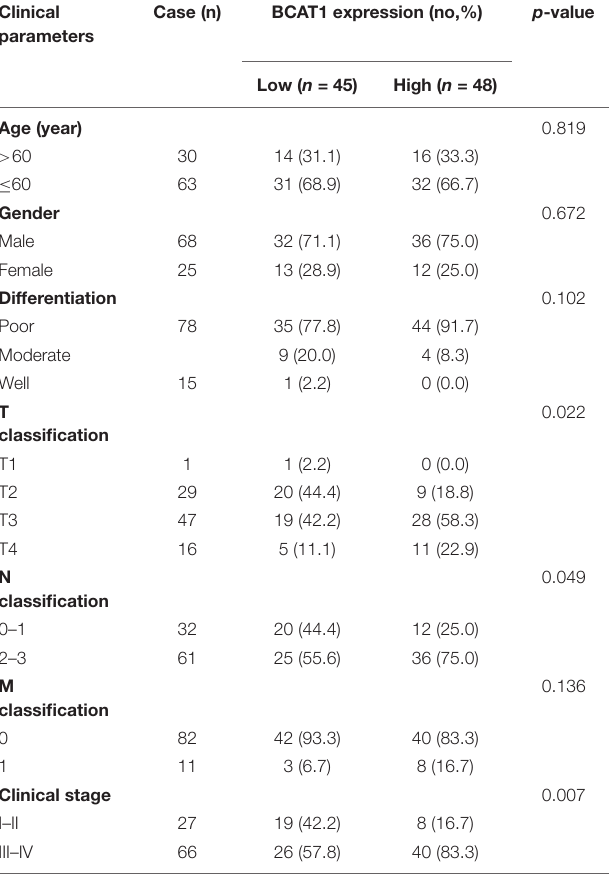
TABLE 1 | Relationship between BCAT1 expression and clinical parameters in 93 GC patients. Clinical